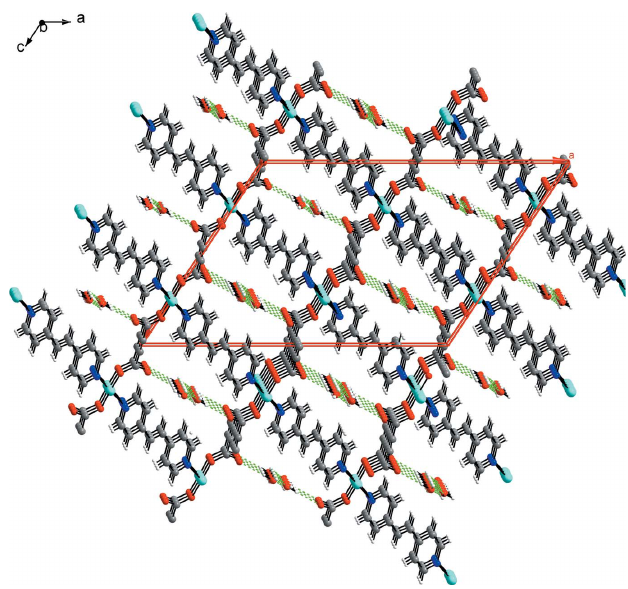
Figure 4 Hydrogen-bonding interactions (green dotted lines) between water solvate molecules forming chains and between these chains and non- coordinating carboxylate O atoms (Table 1). Only the chains formed from the major of the two disordered water molecules are